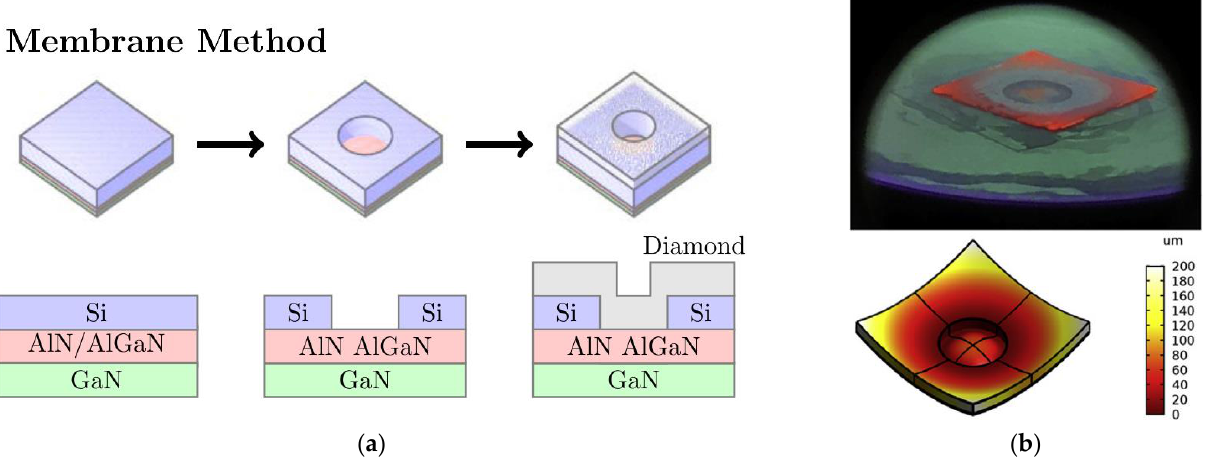
Figure 19. ( a ) Fabrication steps of a GaN-on-diamond membrane. ( b ) Image of the 5 mm-diameter membrane inside the MPCVD system and corresponding thermally-induced mechanical displace- ment (reprinted from [95]; permission conveyed through CCBY 4.0: https://creativecommons.org/ licenses/by/4.0/ (accessed on 7 October